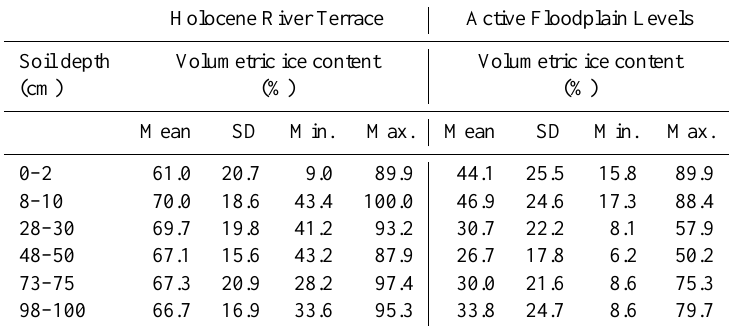
Table 3. Volumetric ice contents for all six investigated soil depths and both geomorphic units, the Holocene river terrace and the active floodplain levels, expressed as percentages with the mean values and the respective standard deviations as well as the minima and maxima. Cores were sampled in April and completely frozen, including the seasonally thawed